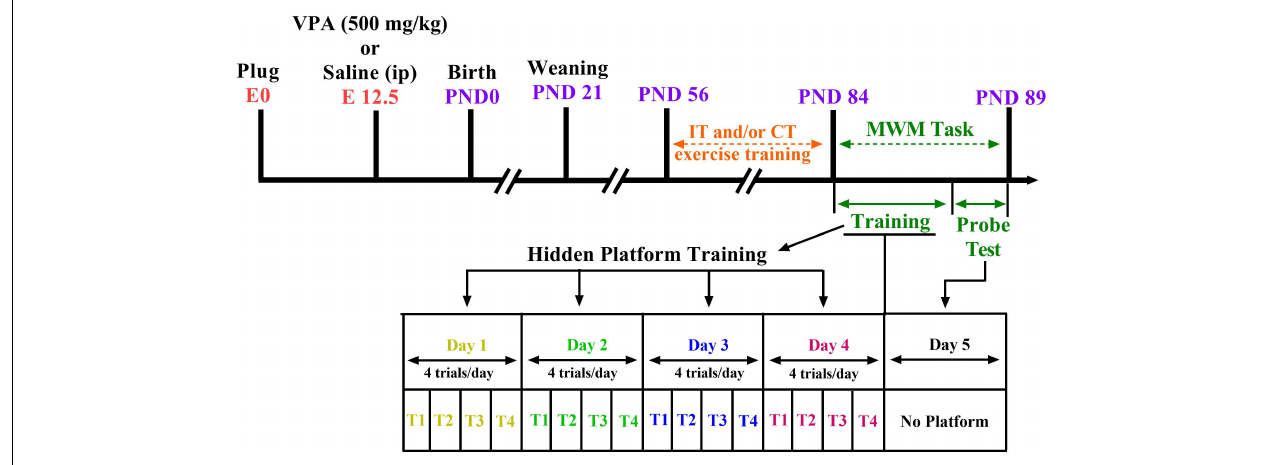
FIGURE 1 | Study design and time diagram of Morris water maze (MWM) task. Two female rats with one male rat were caged overnight and allowed to mate. The first day of pregnancy was determined by the presence of sperm in vaginal smear. On E12.5, valproic acid (VPA)-dams ( n = 8) received single intraperitoneal (i.p.) injection of NaVPA (500 mg/kg, 3.3 ml/kg); saline-dams ( n = 7) received a single injection of saline as vehicle (i.p., 3.3 ml/kg). Offsprings were weaned on P21. Interval exercise training (IT) and continuous exercise training (CT) were started at postnatal day 56. Then, on postnatal days 84–89, the MWM test was conducted on the separate groups of